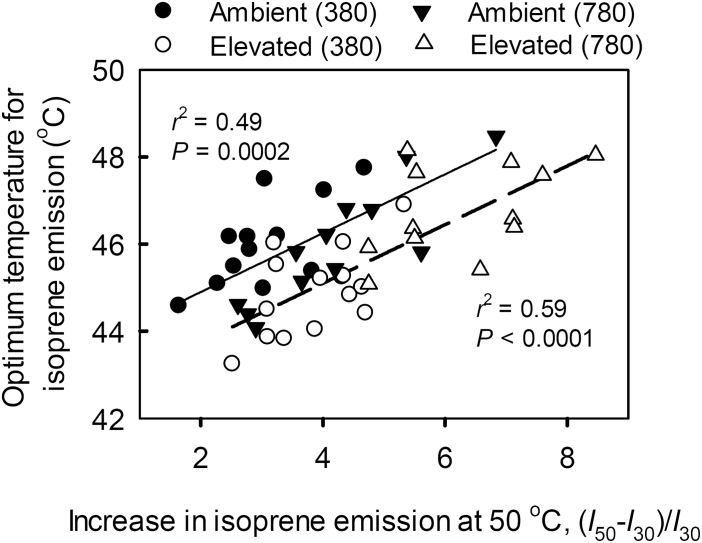
Relationships of the optimum temperature for isoprene emission (Eq. 4) with the relative increase of isoprene emission rate (I) with increasing temperature from 30 to 50 °C (Eq. 2) in hybrid aspen leaves grown under two different CO2 concentrations (ambient vs elevated) and measured at different ambient CO2 concentrations of 380 and 780 μmol mol–1, and at different light intensities of 500 and 2000 μmol m–2 s–1 (symbols for different light intensities not shown separately). Separate regression lines were fitted to the data from different growth CO2 treatments (P<0.05 for the growth CO2 effect according to a common-slope ANCOVA model). Table 1 shows a comparison of average T
opt values at different growth and measurement [CO2] conditions.